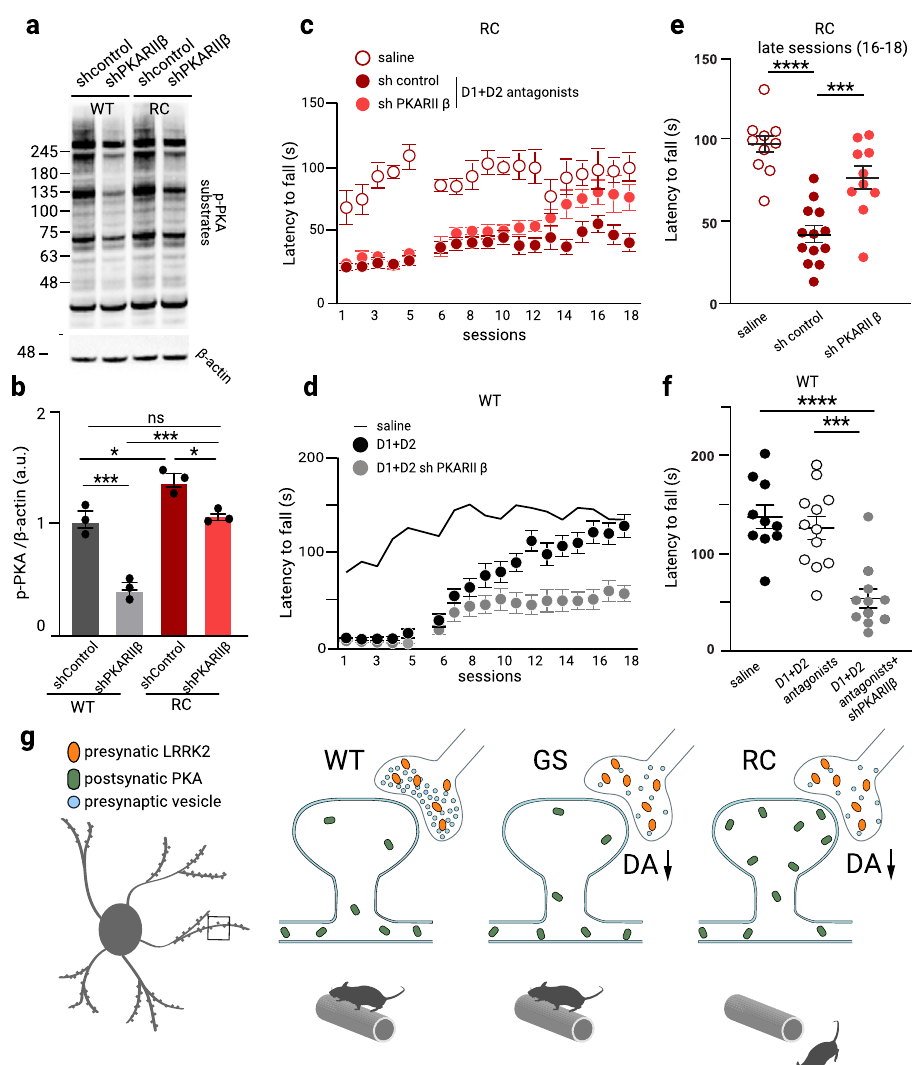
Fig. 6 Aberrant synaptic PKA activities underlie the dopamine-dependent RC impaired motor learning. a Western blot analysis of striatal extracts from WT and RC mice injected with AAV-sh-control and AAV-sh-PKARII β viral constructs probed for p-PKA and β -actin. b Quanti fi cation of p-PKA bands normalized to β -actin. Summary graphs represent the mean, while error bars SEM, * p < 0.05, *** p < 0.001, Tukey post hoc following one-way ANOVA ( n = 3). c , d The latency to fall of RC mice treated with the dopamine receptors antagonists ’ cocktail and injected either with control AAV-sh-control and AAV-sh-PKARII β viruses was assessed in the rotarod paradigm described in Fig. 3a. A subset of mice was administered saline and used as a reference for the effect of D1 and D2 antagonism (saline treated group n RCsaline = 10, D1 + D2 antagonists treated groups n RCsh-control = 13, and n RC-shPKARII β = 10). The average latency in the drug-free recovery phase of the three late sessions (16 – 18) are summarized in e . Asterisks show statistical signi fi cance for Tukey ’ s multiple comparison tests after two-way ANOVA. d Dopamine receptor antagonists treated WT mice were injected with shPKARII β virus, and their latency to fall was assessed in the accelerating test. WT mice administered saline and cocktail are used as reference, saline treated group n WT = 10, D1 + D2 receptor antagonist treated groups n RC = 12, and n RC-shPKARII β = 11. The average latency in the three late sessions (16 – 18) of the rotarod test is shown in f . Asterisks show statistical signi fi cance for Tukey ’ s multiple comparison tests after two-way ANOVA. g Working model of aberrant PKA synaptic activities at a blowup of a spine of an SPN (left). Presynaptic dysregulation of LRRK2 activity in RC and GS mutants has a common disruption of the synaptic vesicle cycle, which leads to decreased dopamine release. In addition, in RC mutants, there is a postsynaptic translocation of PKA into the dendritic spines with aberrant increased PKA activity, which disrupts synaptic signaling and interferes with motor learning and performance (measured by decreased latency to fall off